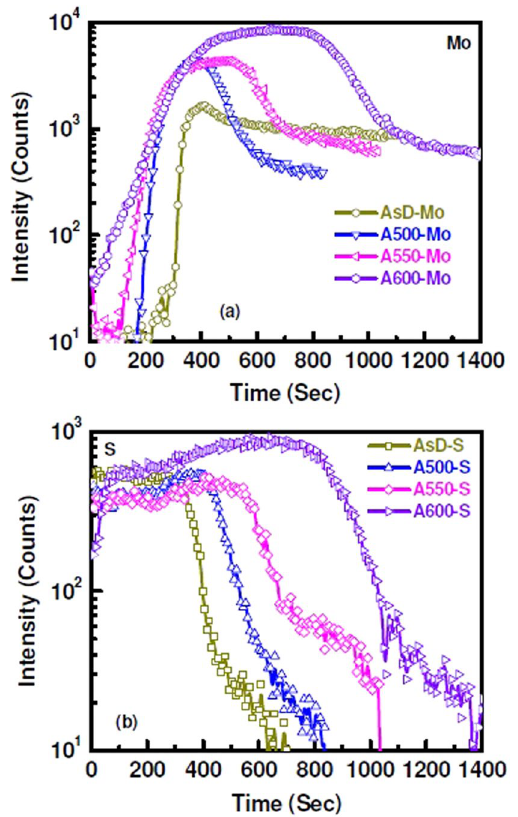
Figure 6. Comparison of ( a ) Mo and ( b ) S distribution with varying annealing temperature. “AsD” denotes as deposited sample and “A500”, “A550”, “A600” denotes samples annealed at 500 ο C, 550 ο C, and 600 ο C